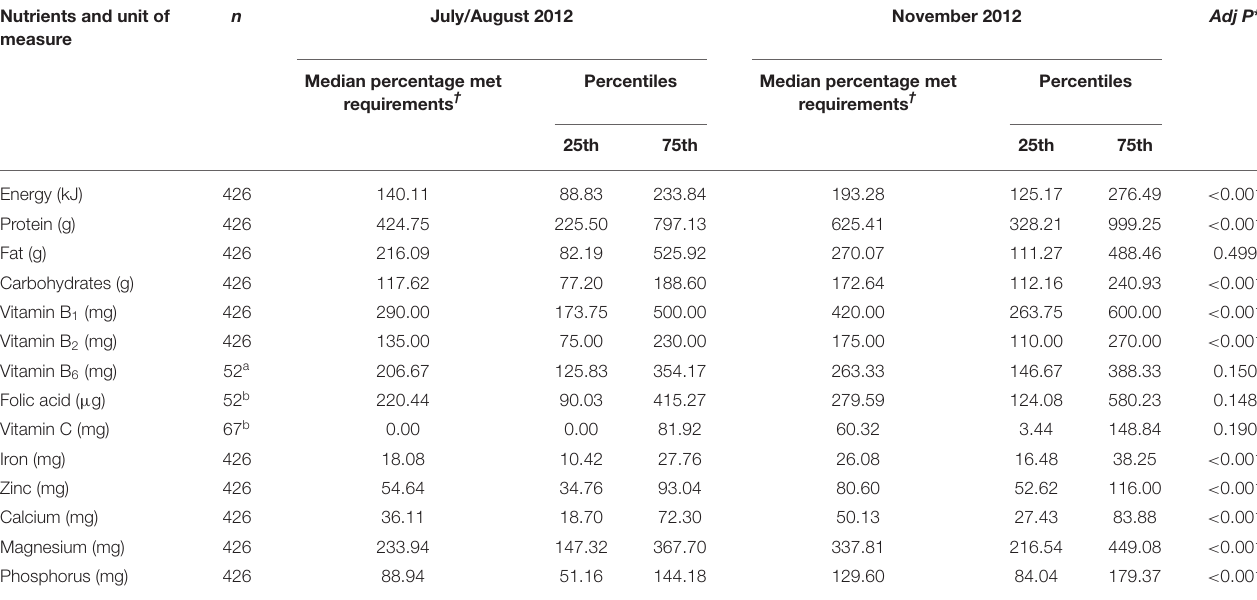
TABLE 5 | Median percentage met requirements for energy and nutrients from complementary foods among children 6–23 months in July/August and November 2012 in Western Kenya. Nutrients and unit of measure